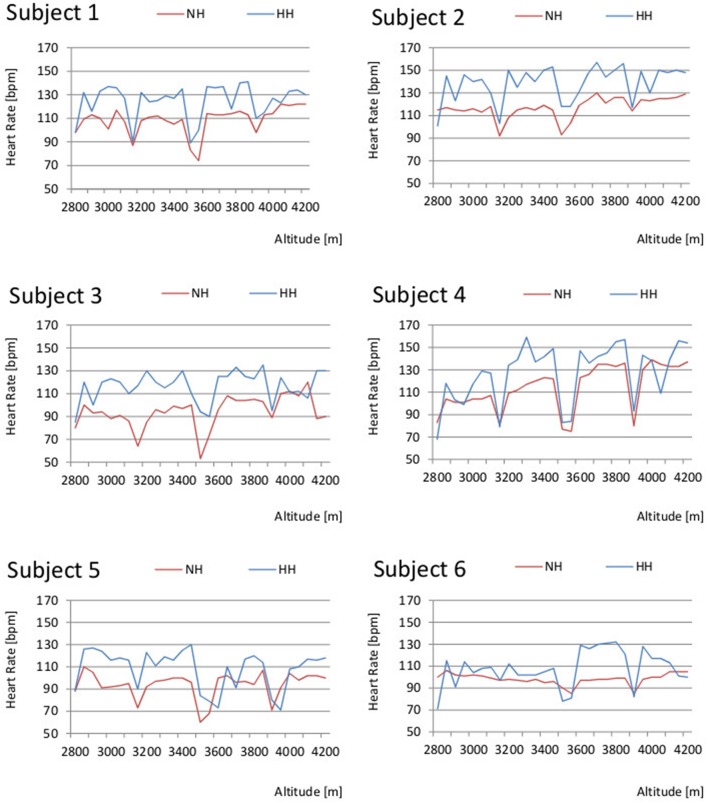
Comparison of individuals' heart rate (HR) in normobaric hypoxia (NH) and hypobaric hypoxia (HH).